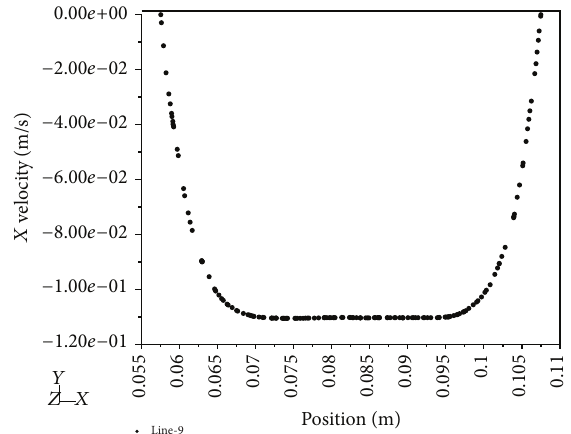
Figure 10: The length of reflux at point B.